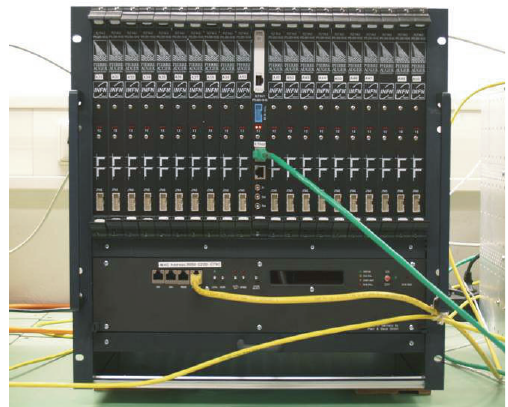
Figure 2: Image of the DAQ system in the USCT configuration. It is composed of one Second-Level Card (SLC) for measurement control and communication management (middle slot) and 20 First-Level Cards (FLC) for parallel sensor signal acquisition and data storage.